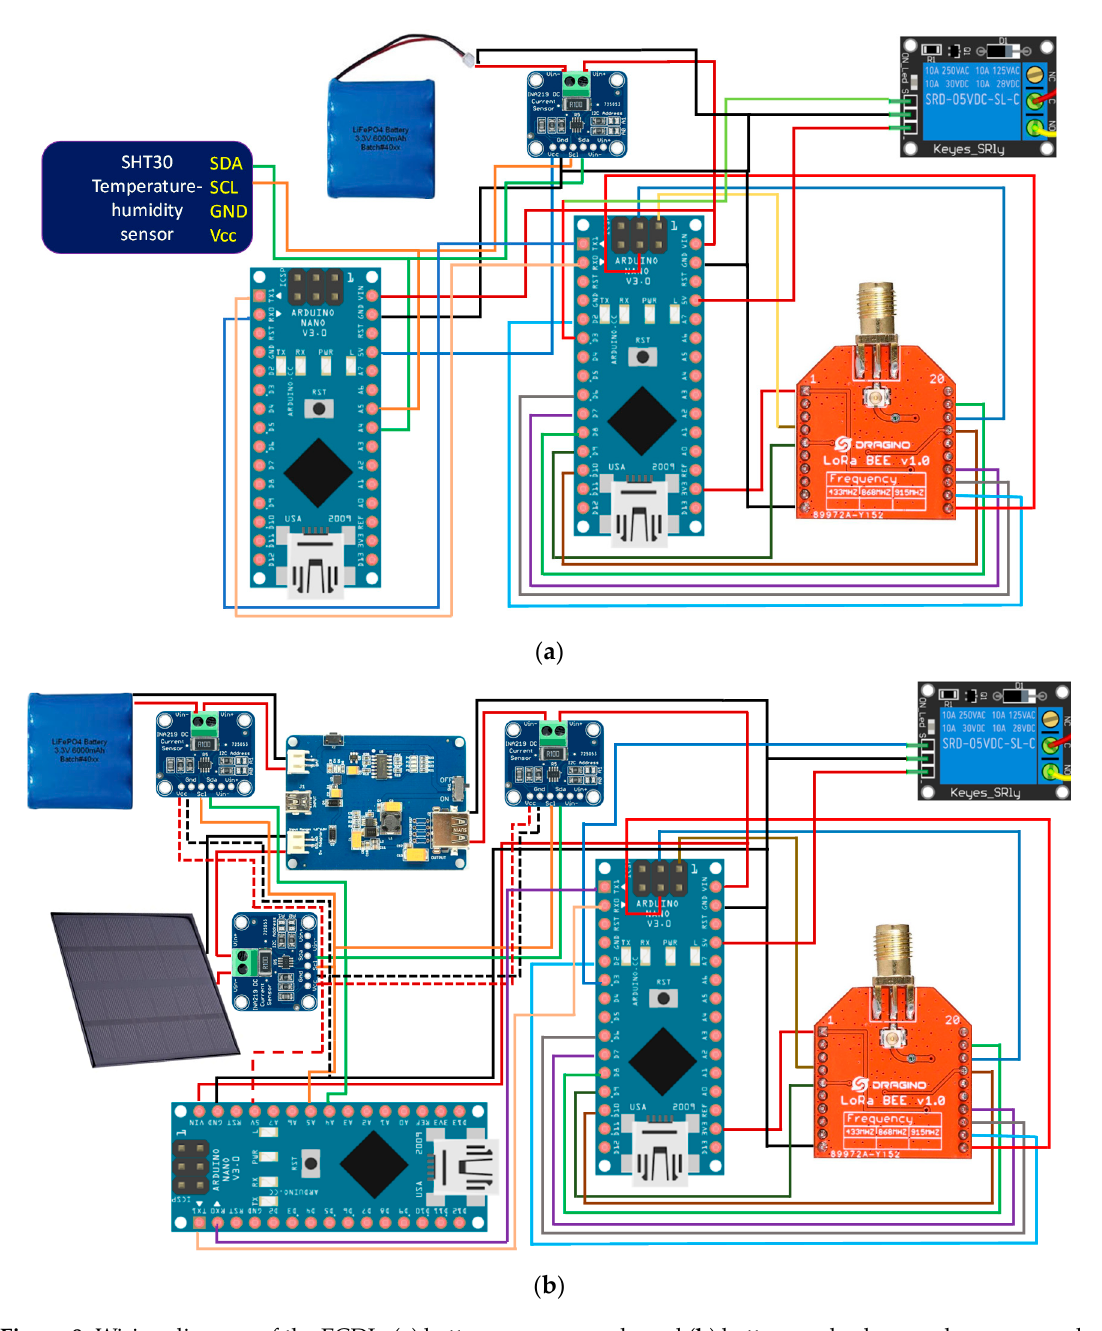
Figure 8. Wiring diagram of the ECDL: ( a ) battery power supply and ( b ) battery and solar panel power supply.